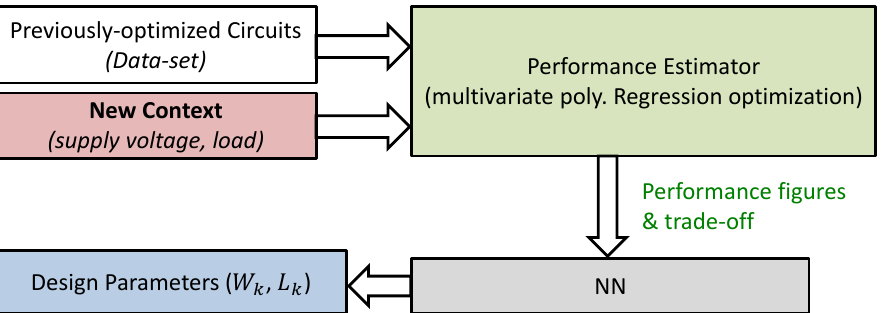
Figure 6. Conceptual bloc diagram of the hybrid technique used in [33].